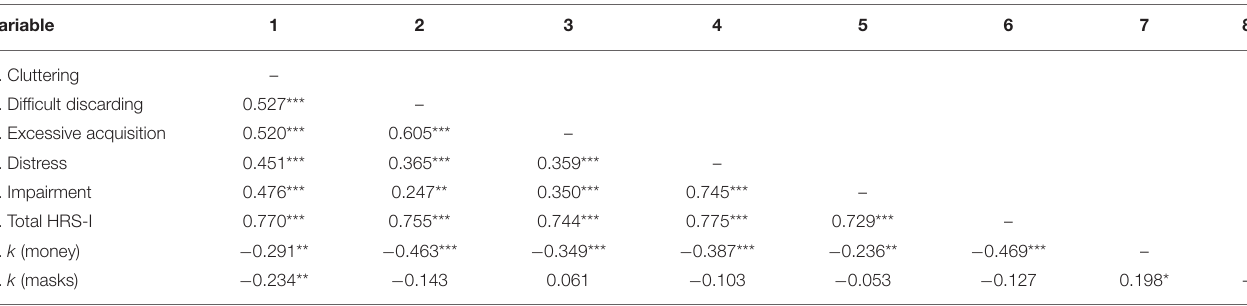
TABLE 3 | Pearson’s correlations between hoarding dimensions and discount rate (overall) in the money ( k money) and masks version ( k masks) of the discounting task. Variable 1 2 3 4 5